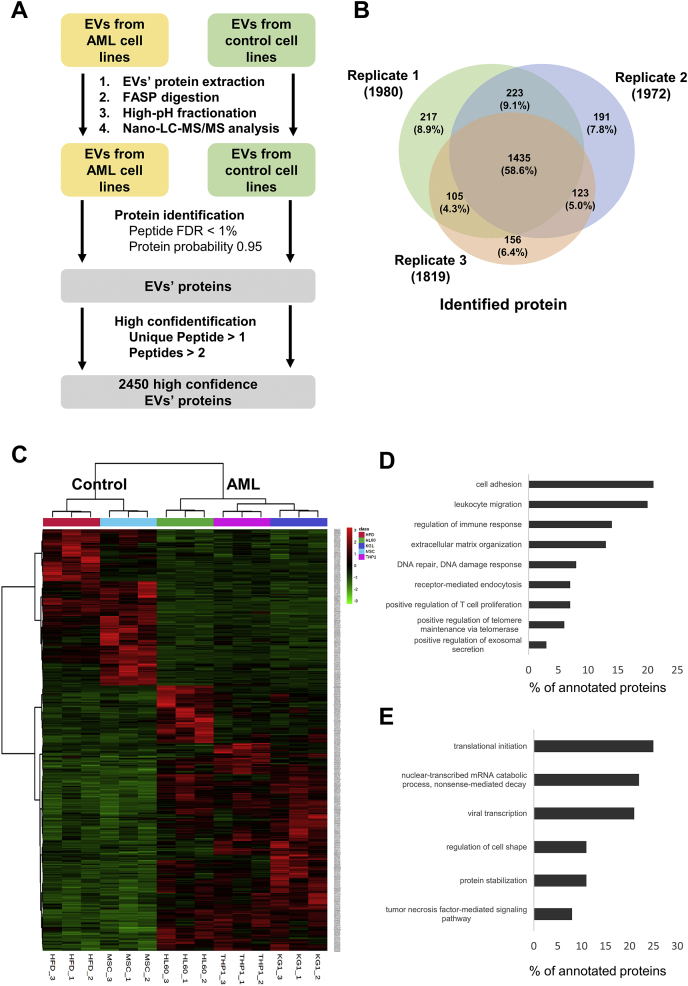
Proteins identified by LC-MS/MS analysis and protein quantification.A, quantitative proteomic analysis of the EVs isolated from AML cells (HL-60, KG-1, and THP-1) and control cells (HDFa and hMSCs). B, the Venn diagram showing the overlapping proteins from the protein profiles of three replicates. A scheme of the proteomic approach for the identification of EV proteins. C, hierarchical clustering of differentially expressed proteins (DEPs) among EVs derived from AML cell lines. The heat map graphically represents the proteins from the EVs derived from AML cell lines whose expression levels were significantly different compared with those derived from control cell lines. D and E, functional analysis of DEPs was conducted using DAVID software to analyze gene ontology (GO) to identify biological processes. Upregulated biological processes in EVs derived from AML cell lines compared with EVs derived from control cell lines (D) and downregulated biological processes in EVs derived from AML cell lines versus EVs derived from control cell lines (E). Note that proteins generally have several GO annotations (annotated proteins p-value < 0.05). AML, acute myeloid leukemia; EVs, extracellular vesicles; HDFa, human dermal fibroblasts, adult; hMSCs, human mesenchymal stem cells; LC-MS/MS, liquid chromatography–tandem mass spectrometry.